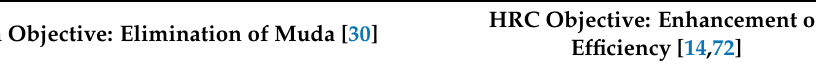
Table 3. Comparison of scope between lean’s goal to eliminate overprocessing, waiting, and unneces- sary motion and HRC’s goal of improved